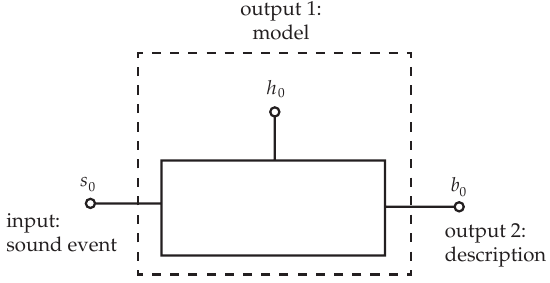
Figure 2. Schematic representing an auditory experiment.